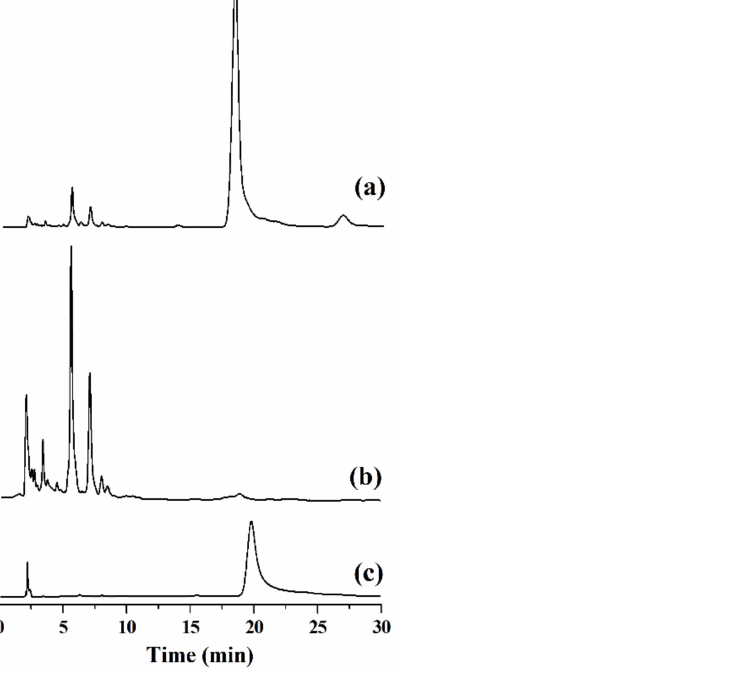
Figure 12. HPLC chromatograms of the root extract of SBG ( a ), the root extract of SBG after adsorption ( b ), and baicalin obtained from the desorption solution ( c